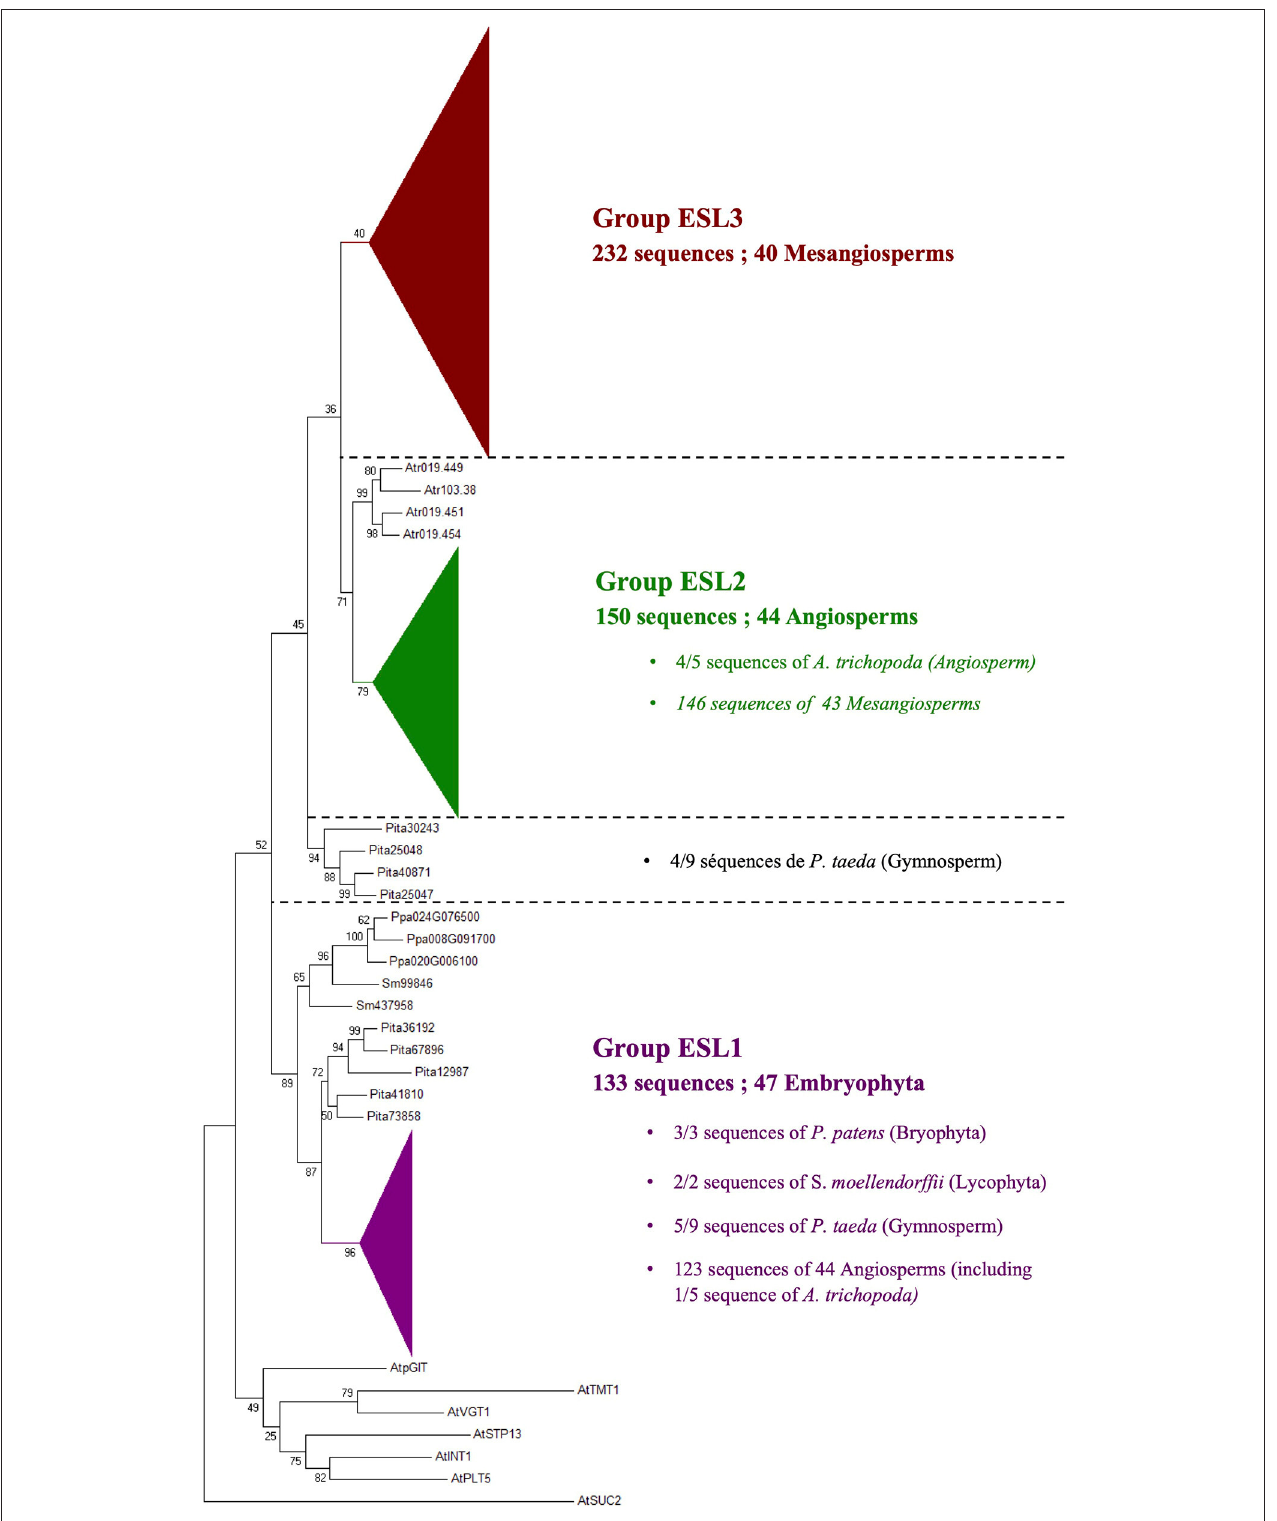
FIGURE 2 | The maximum likelihood phylogeny of ESL sugar transporter proteins. The tree was produced by aligning 519 amino acid ESL sequences identified in 47 Embryophyta using ClustalW and was then built using the software Molecular Evolutionary Genetics Analysis (MEGAv6, Tamura et al., 2013). Jones–Taylor–Thornton (JTT) amino acid substitution model was used and the bootstrap consensus tree was inferred from 1,000 replicates. The percentage of replicate trees in which the